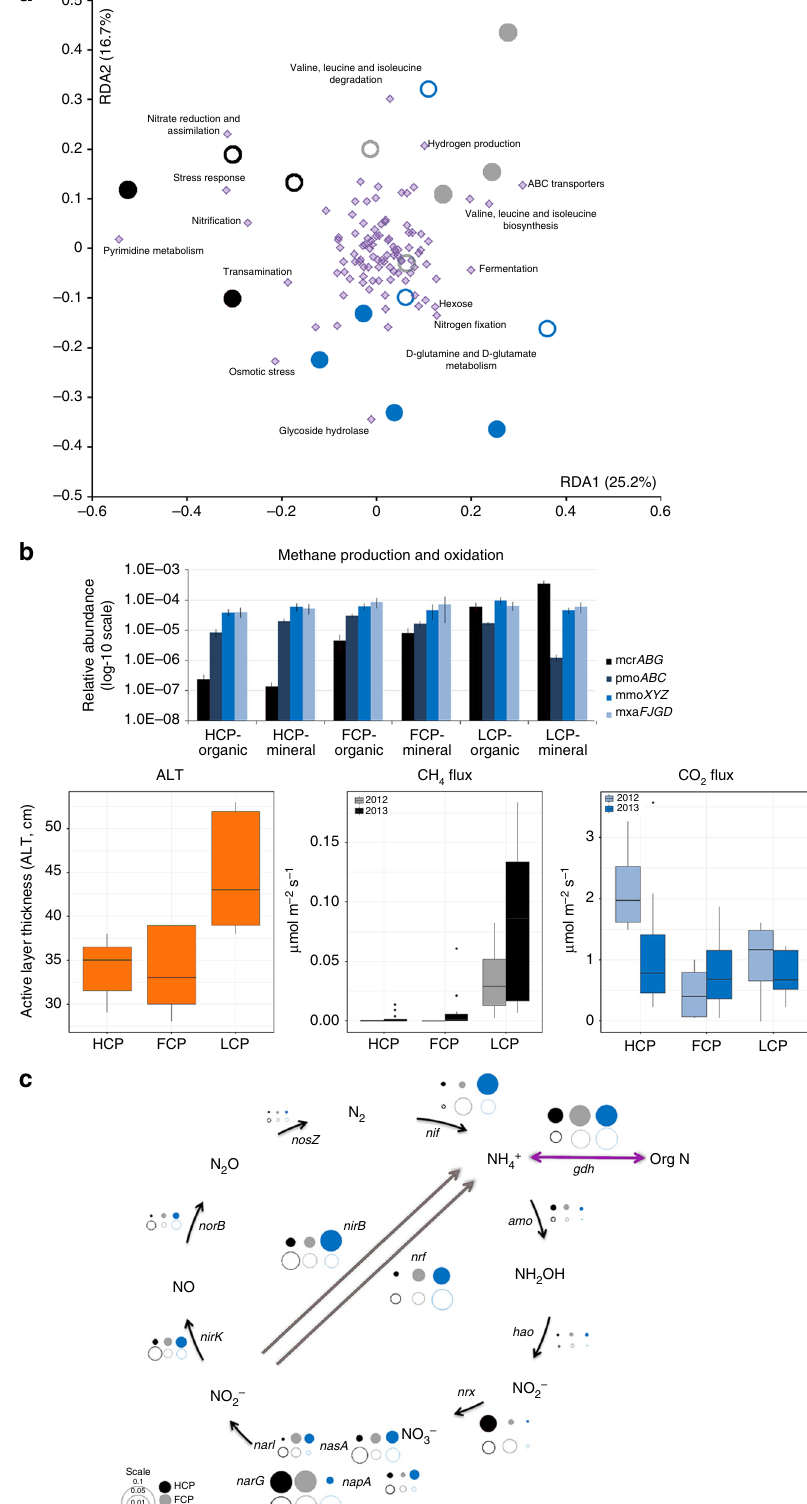
Table 5). We assembled full-length 16S sequences in half of the genome bins, ranging between 82 and 95% similarity to 16S sequences from previously sequenced genomes (Supplementary Table 6). Proteobacteria , Bacteroidetes , Acidobacteria , and